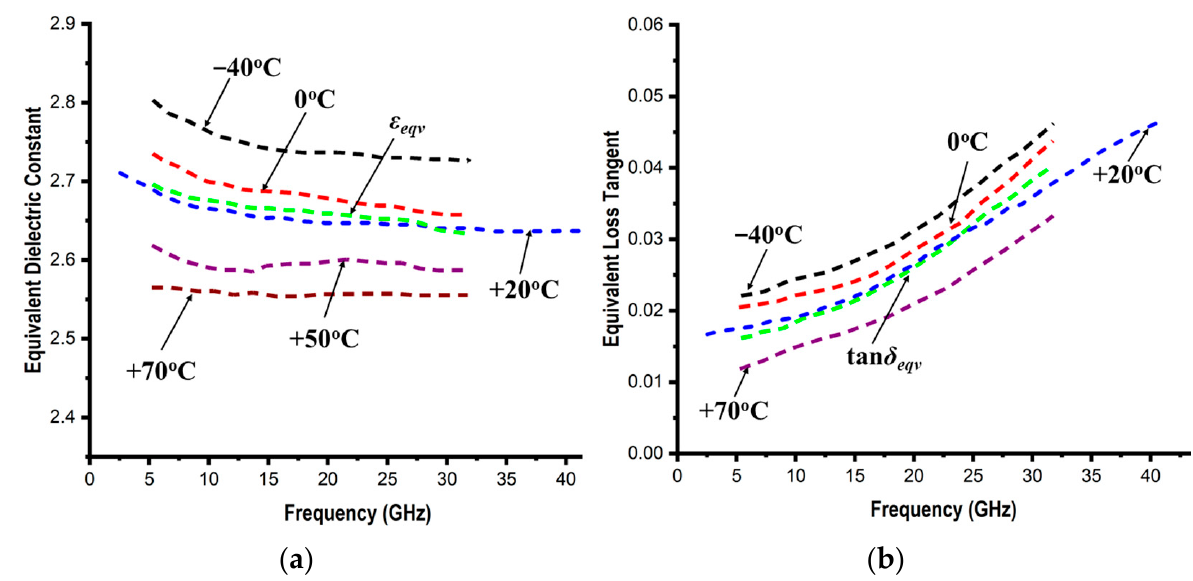
Figure 8. Variation in equivalent dielectric parameters: dielectric constants ( a ) and loss tangents ( b ) of PDMS at di ff erent temperatures with respect to the frequency.